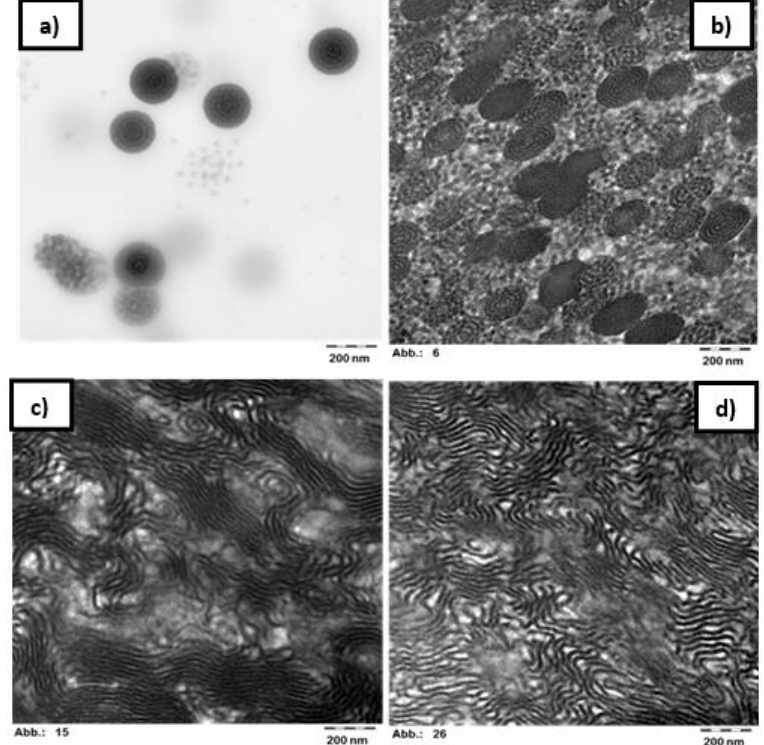
Figure 8. TEM images of the sample p(St15-2EHA70-St15) stained with RuO 4 ( a ) particles dispersion embedded in hydroxyethyl cellulose ( b ) film dried at room temperature ( c ) film annealed at 100 °C and ( d ) film cast from THF-solution. The bar of all the images is 200 nm.